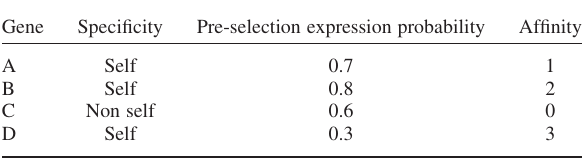
TABLE II A sample set of parameters used in a